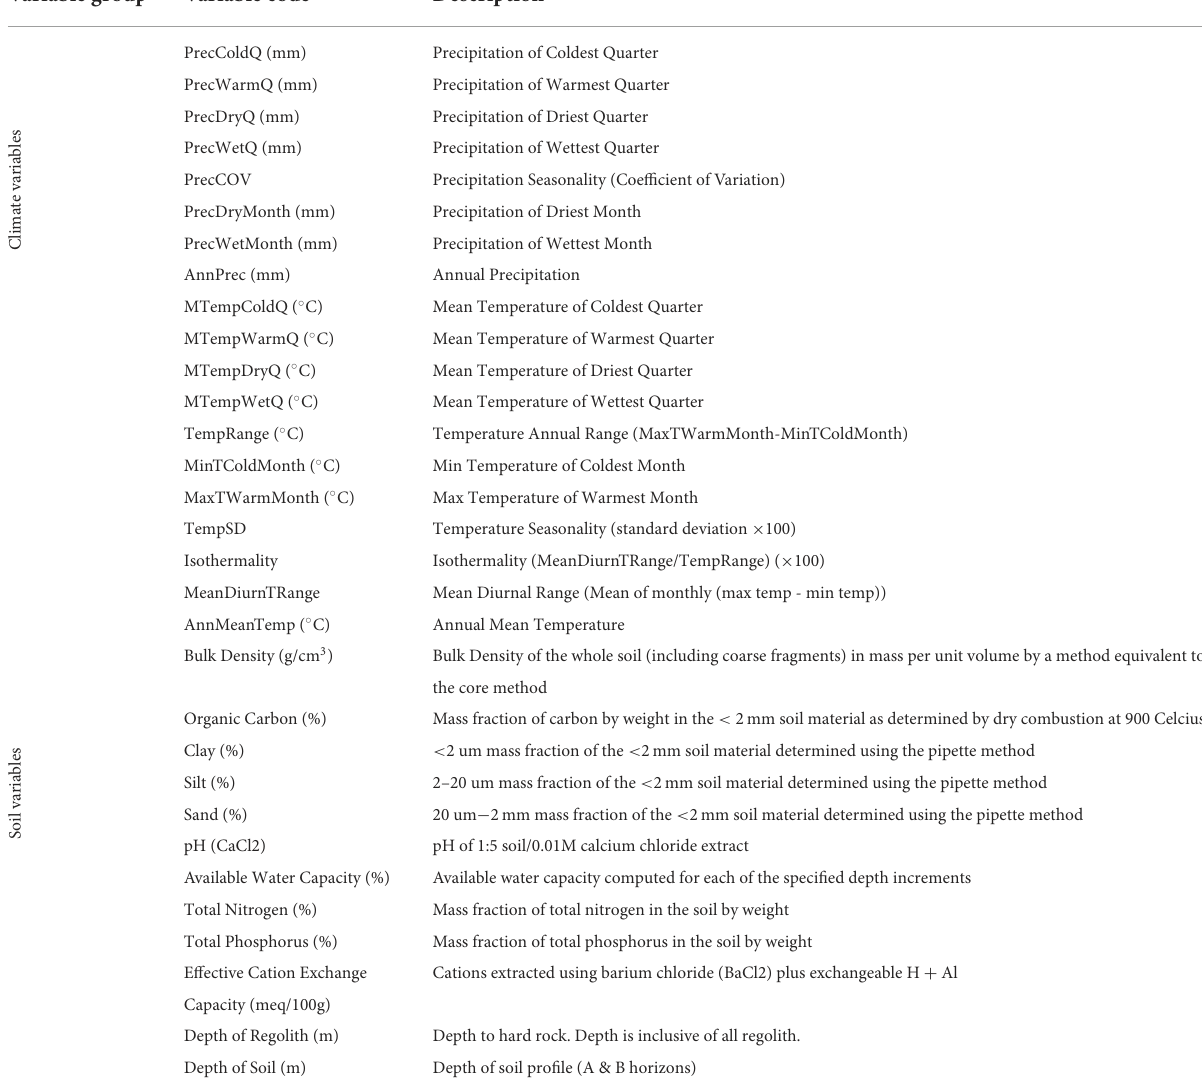
TABLE 2 The climatic variables (Fick and Hijmans, 2017) and the soil variables (Grundy et al., 2015) used in random forest modelling to predict the potential distributions of bush foods across Australia. Variable group Variable